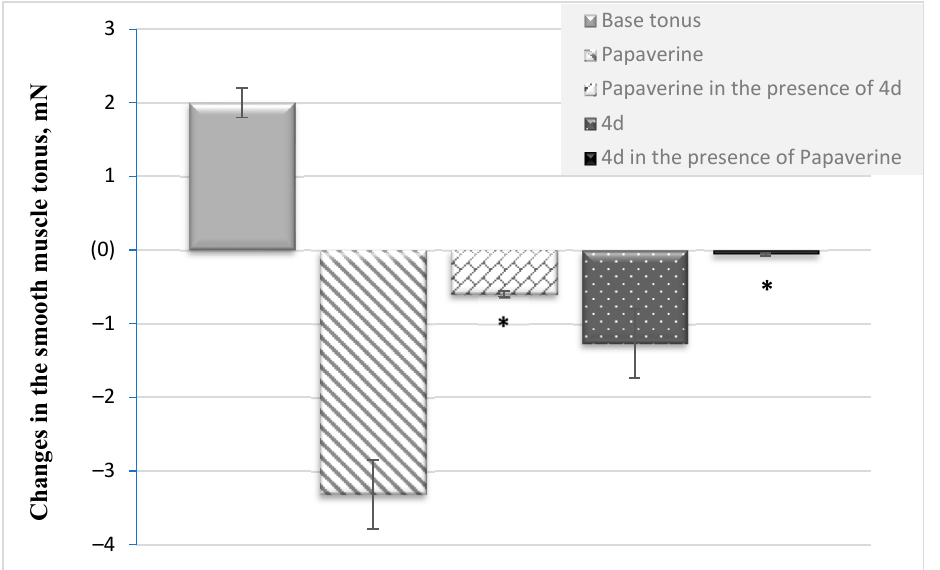
Figure 2. Relaxation effects caused by 1 × 10 − 6 mol/L papaverine and 5 × 10 − 5 mol/L 4d on SMPs at single or combined administration (n = 12); * p < 0.05.